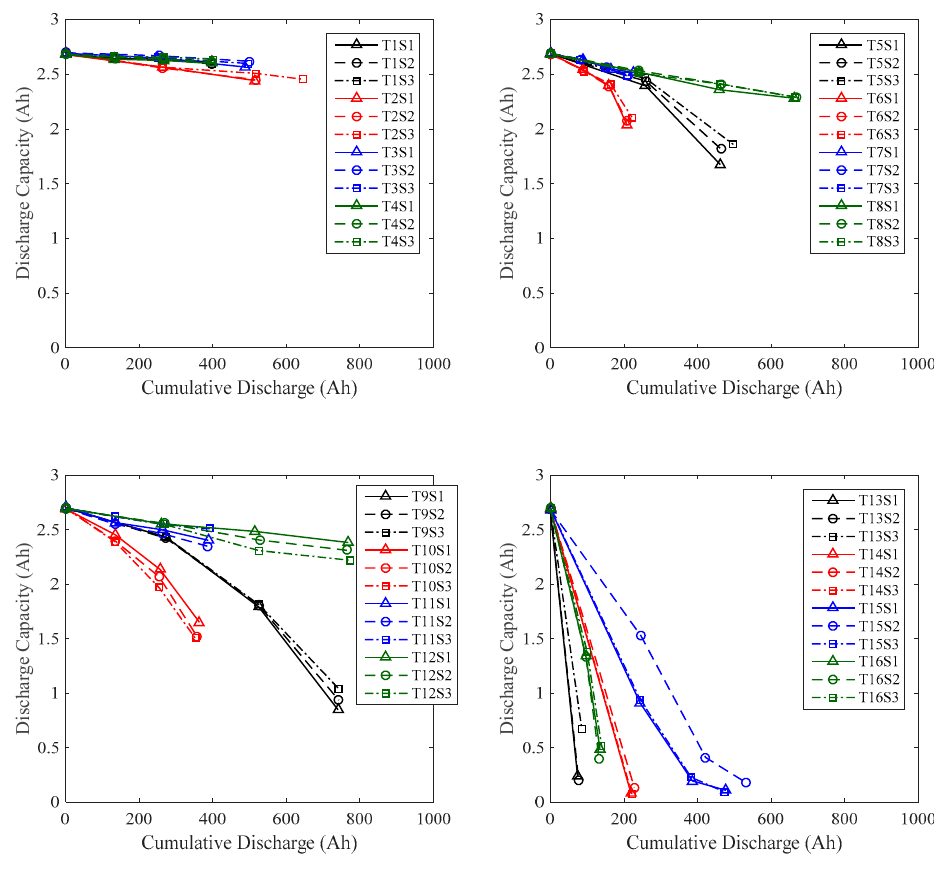
Figure 1. Variation of discharge capacity with cumulative discharge (Ah) for Manufacturer 1.